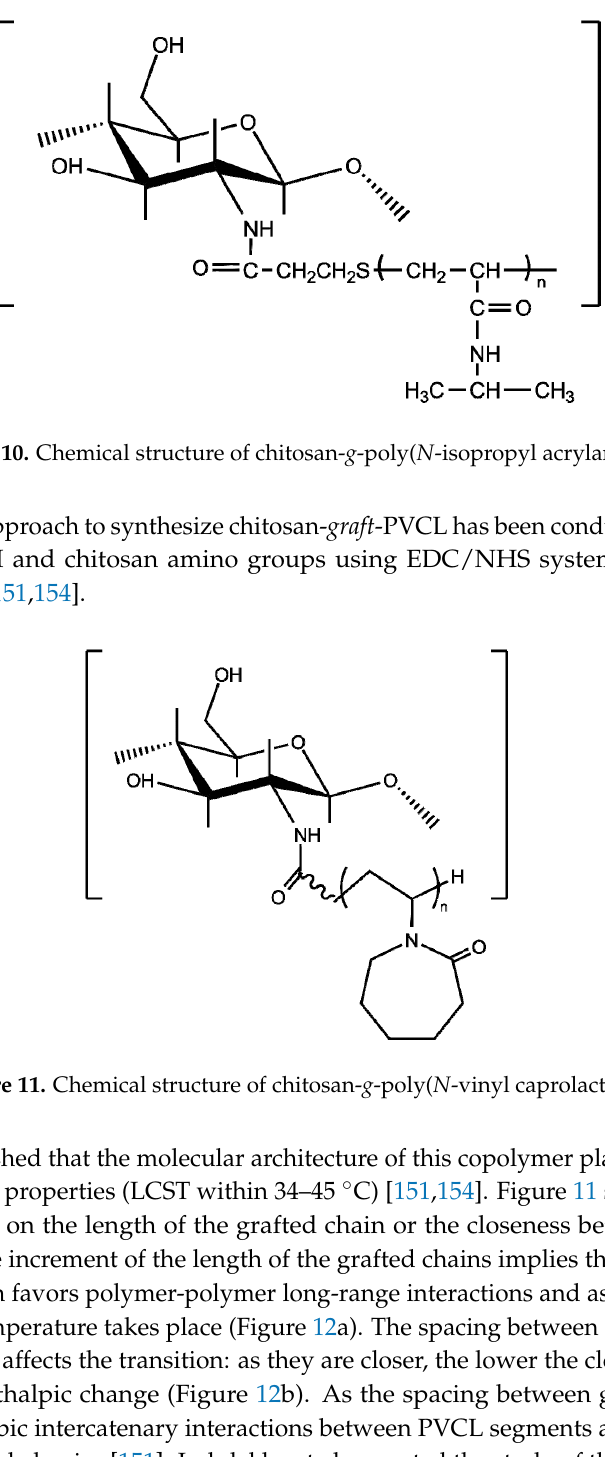
Figure 9. Chemical structure of chitosan- g -poly(ethylene glycol). Chitosan- g -PNIPAm copolymer has also been synthesized by the graft onto method via the amidation between carboxylic-end PNIPAm chains and chitosan amino groups using carbodiimide compounds like DCC [142], or EDC (Figure 10) [143–145]. Similarly, the same reaction, but between O -carboxymethyl chitosan and amino-end PNIPAm chains, has also been proposed [146], having the